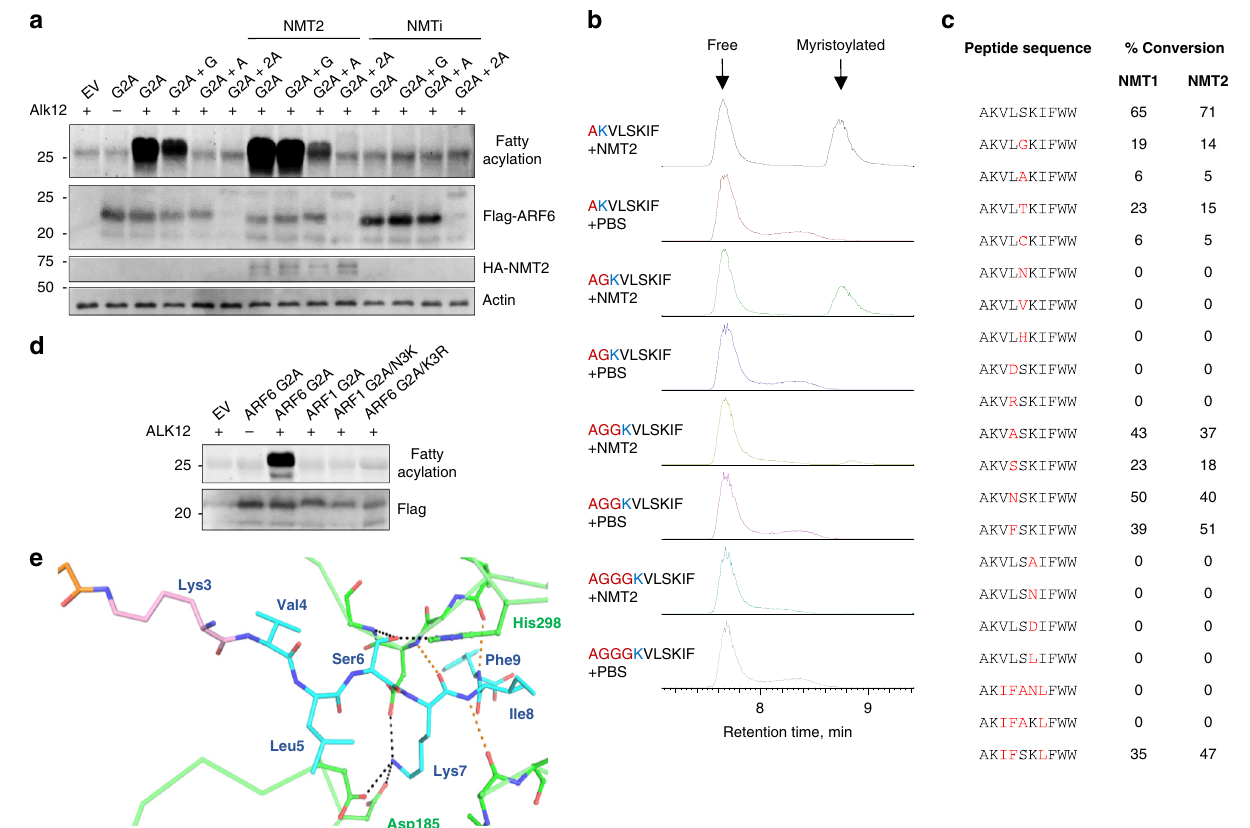
Fig. 3 Sequence requirement for NMT lysine myristoylation. a Cellular Alk12 labeling results with the indicated mutants showing that NMT can accommodate other positions of K at the N-terminus in cells. The mutant containing two additional alanine residues at the N-terminus could not be stably expressed. b NMT can accommodate other N-terminal positions of K in vitro on synthetic peptides. Ion chromatograms searched for the substrate and product ions are shown. c Amino acid sequence preference for NMT lysine myristoylation on ARF6 G2A-derived peptides. Red letters represent changed residues. The sequence IFANL is the ARF1-derived sequence. The product was detected by LC-MS and the percentage of conversion was calculated from the substrate and product peak areas on HPLC UV traces. d Alk12 labeling of the indicated mutants transiently overexpressed in HEK293T cells showing that, unlike ARF6 G2A, ARF1 G2A/N3K is not myristoylated. e Peptide recognition for Lys3 myristoylation appears similar to that for Gly2 myristoylation. NMT2 residues are shown in green. Hydrogen bonding to Ser6 by His298 and Gly472 backbone nitrogen and to Lys7 side chain by a cluster of aspartates 183, 185, and 471 are shown as black dotted lines. Further hydrogen bonding to the backbone of the peptide (orange dotted lines) is also the same as in previous